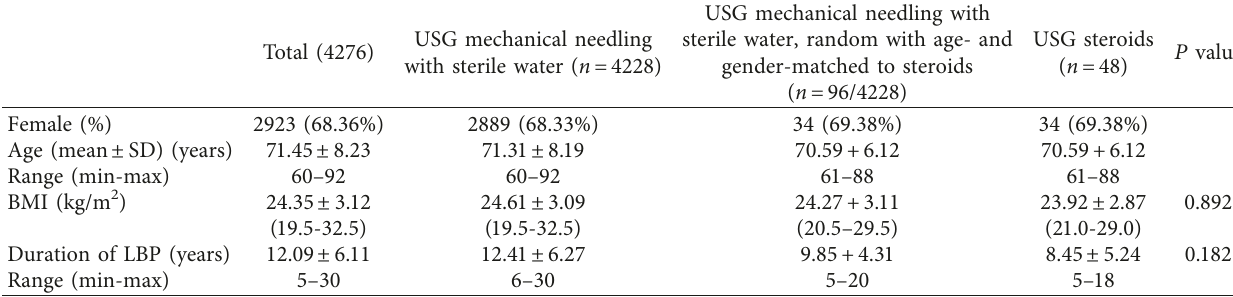
Table 1: General characteristics.